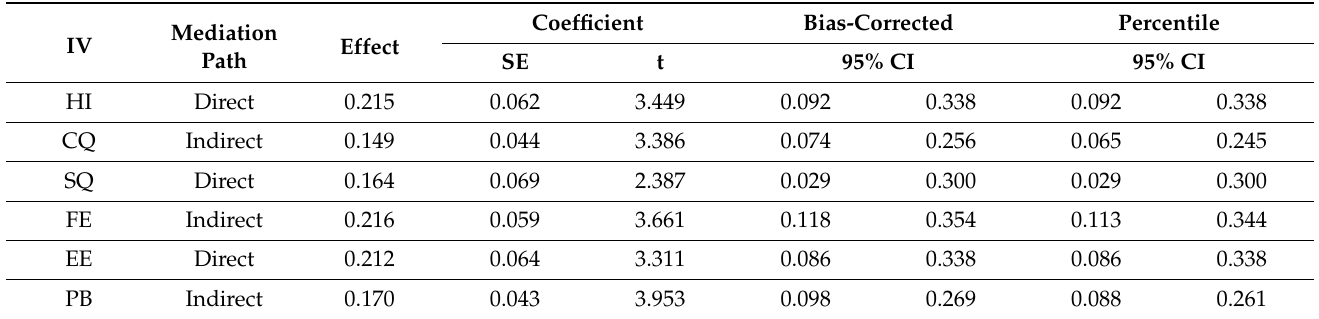
Table 6. The mediating roles of emotional experiences in the relationships between system character- istics and participation.